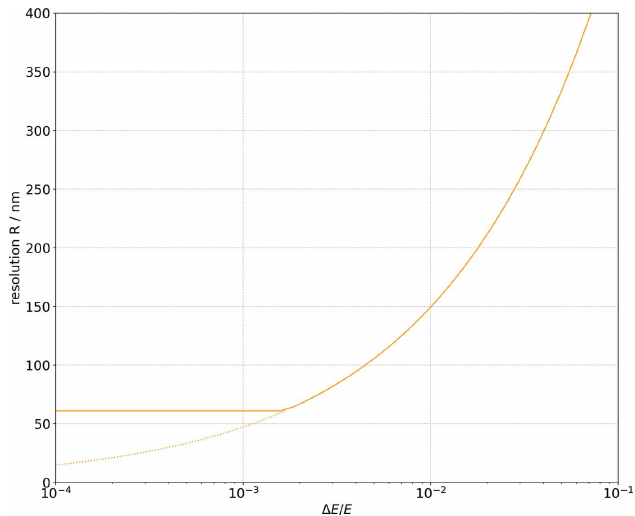
Figure 1 Plot of the resolution limit [as given by equation (5)] over the relative energy bandwidth. The achievable resolution deteriorates very quickly once beyond the acceptable (cid:2) E = E as outlined in equation (5). For (cid:2) E = E smaller than the Rayleigh criterion, the energy bandwidth limited resolution curve is continued as a dotted line. This example is calculated with D = 120 m m, (cid:2) r = 50 nm, N =